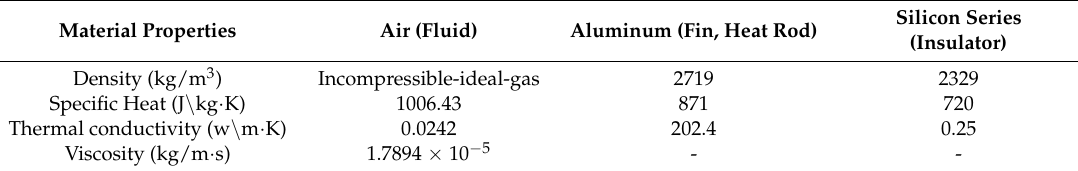
Table 2. Material properties used in the Computational Fluid Dynamics (CFD).